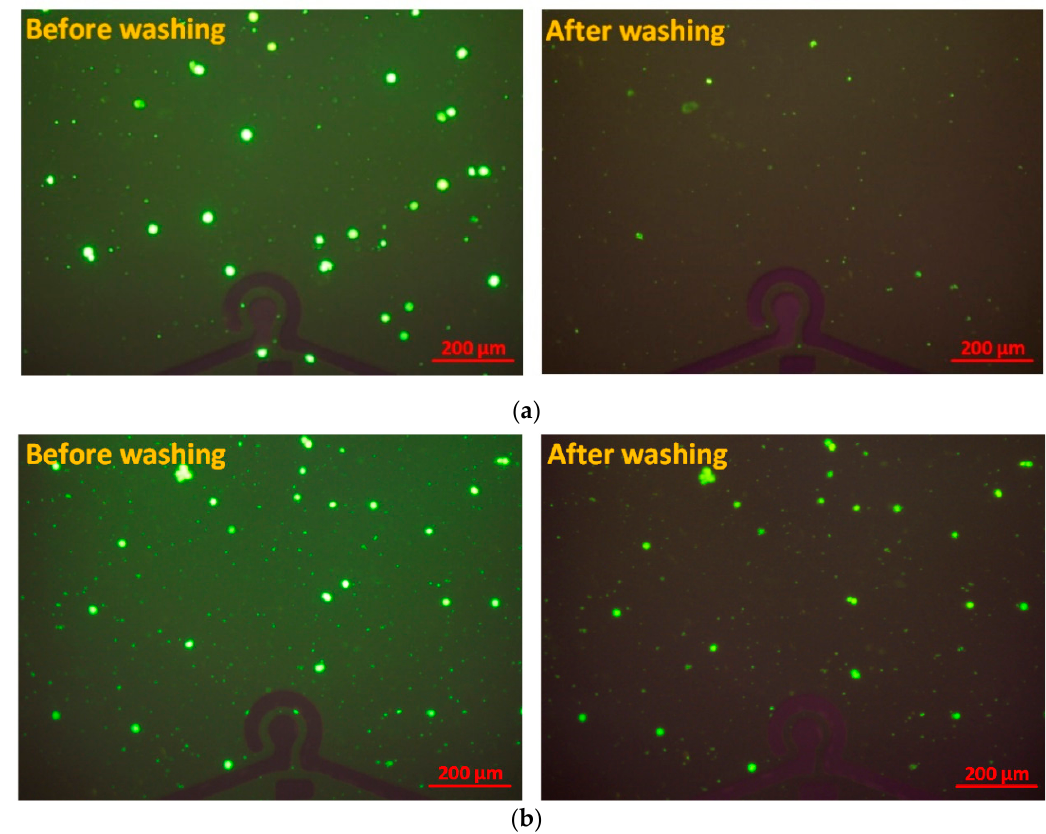
Figure 5. Fluorescence microscopic images of A549 cell samples during the washing and capture process onto the aptamer-modified electrodes area taken at the cell concentration of 5 × 10 2 cells/µL: ( a ) Without SAM of AuNPs; ( b ) With SAM of AuNPs around the microelectrodes.